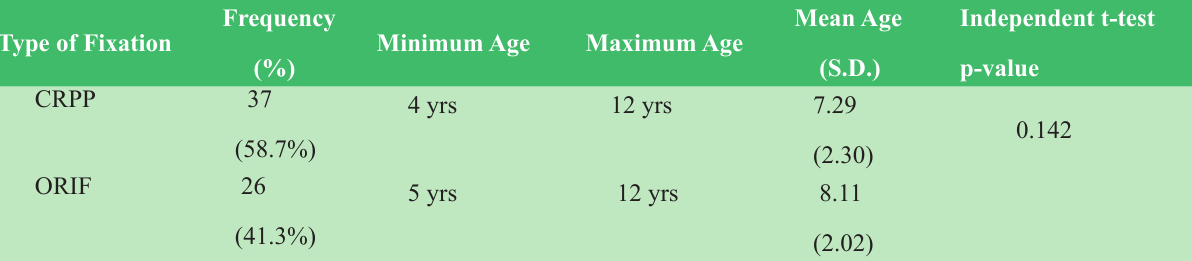
Table 1: Mean Age Vs Type of Fixation Type of Fixation